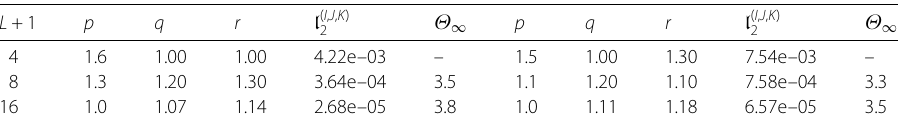
Table 6 Errors and order for UM-FOCS and EEG-TOCS in Example